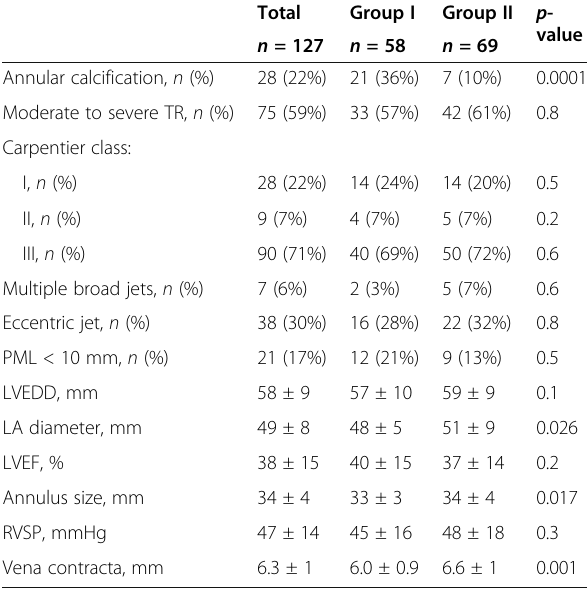
Table 2 Echocardiographic preoperative characteristics